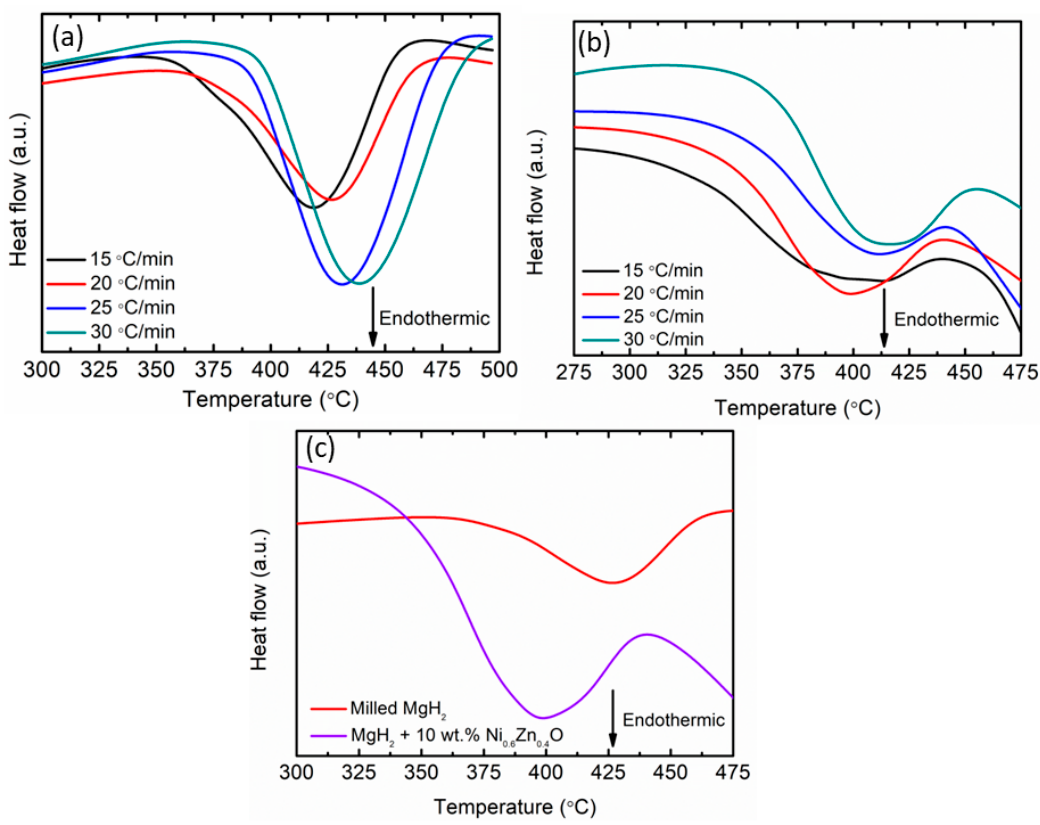
Figure 5. DSC traces for ( a ) milled MgH 2 , ( b ) MgH 2 –10 wt.% Ni 0.6 Zn 0.4 O samples at 15, 20, 25 and 30 °C/min and ( c ) DSC traces at 20 °C/min for milled MgH 2 and MgH 2 –10 wt.% Ni 0.6 Zn 0.4 O samples.